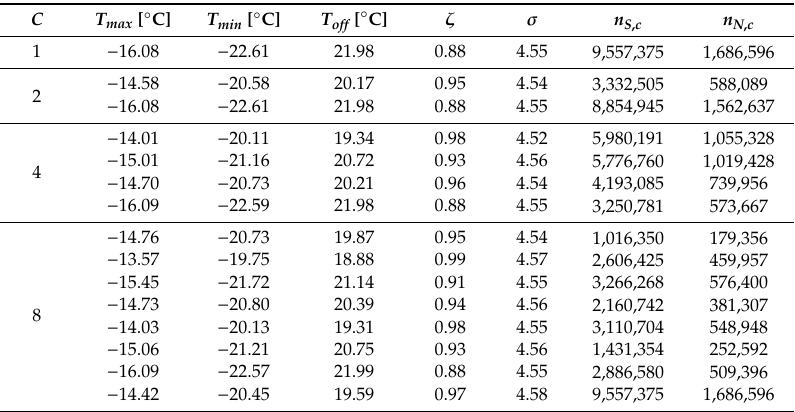
Table A1. Characteristics of